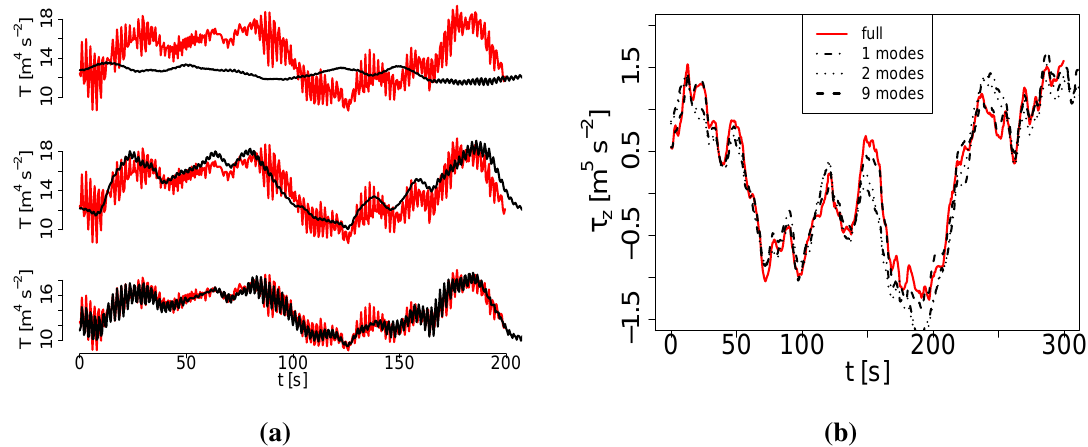
Figure 8. ( a ) The measure T for different numbers of modes used for the reconstruction. The red lines show T for the original field, while the black line shows T of a reconstructed field (( top ) two modes; ( middle ) three modes; ( bottom ) 10 modes); ( b ) Dynamics of the measure τ for different numbers of modes used for the reconstruction. Note that since the z reconstruction is already quite good with one mode, the lines lie almost on top of each other. However, there is still a visible improvement in the case of nine modes.